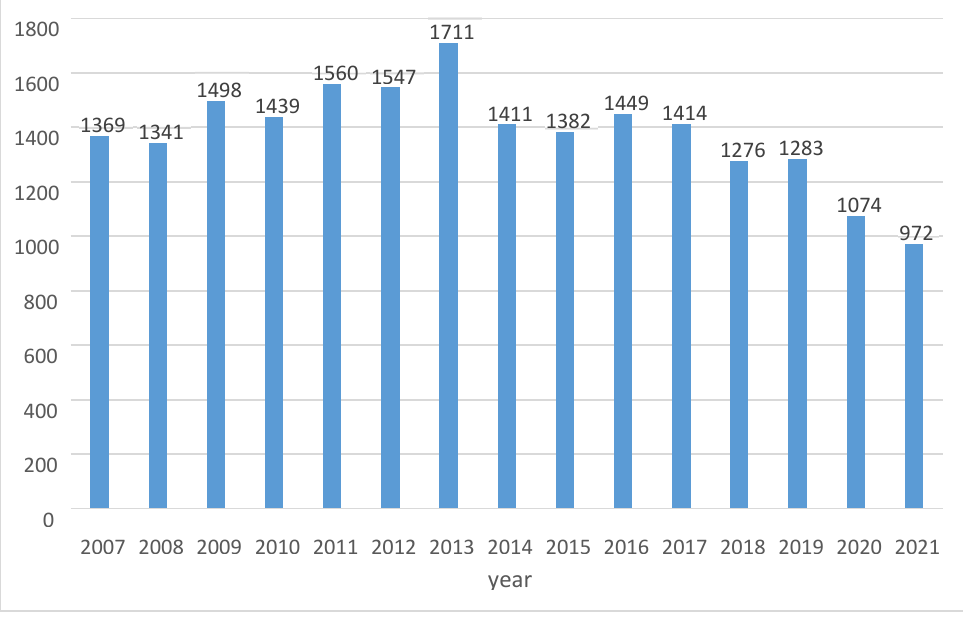
Figure 1. Number of claims filed per year.